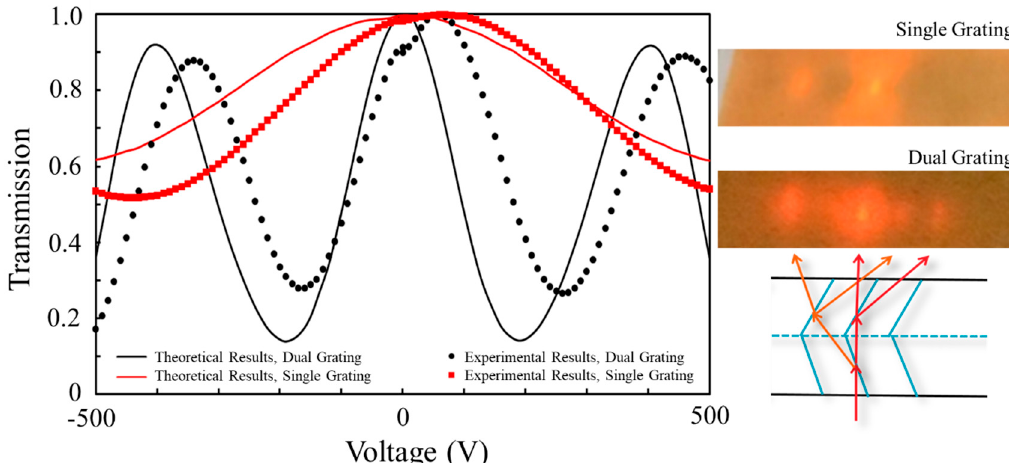
Figure 4. Transmission curves of the dual-grating (in black) and the single-grating (in red) configurations. The solid lines show the theoretical predictions calculated using Equations (A5) and (A11), respectively for the single-grating and the dual-grating configurations. The circle and square markers show the experimental results. The inset pictures show the typical diffraction patterns of the single-grating and the dual-grating samples viewing by an infrared sensor card.